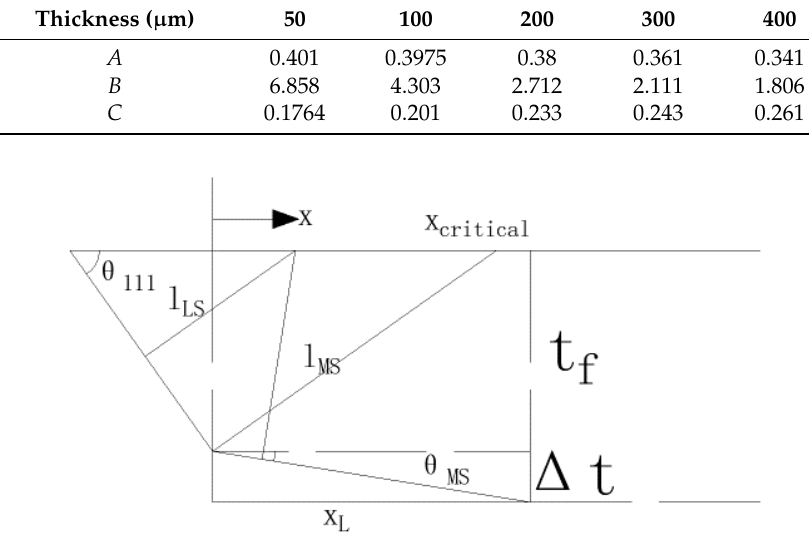
Figure 8. Distance between the surface of the ribbon and the respective solidification interfaces control the relative amount of heat flow at each interface.